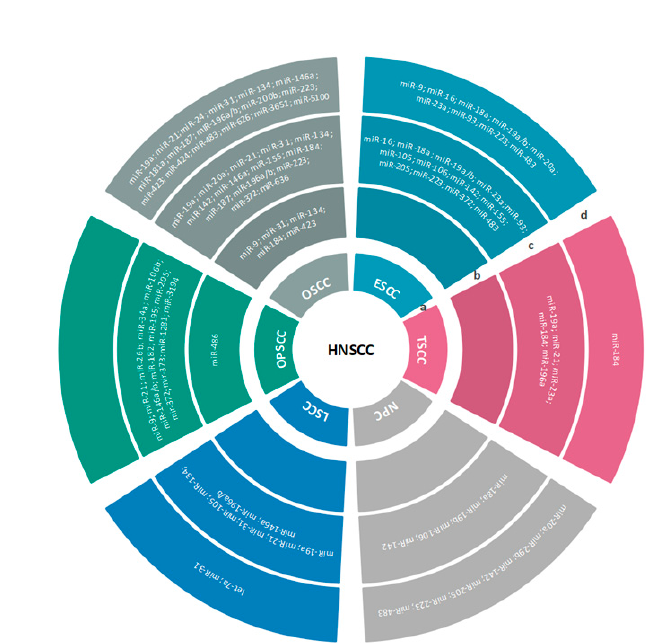
Figure 1. Overview of the most significant miRNAs that are upregulated in HNSCC. The first inner ring represents the subtypes of HNSCC ( a ); the second, third, and fourth rings represent miRNAs detected in saliva ( b ); tumor tissues ( c ); serum, plasma, or peripheral blood ( d ) of HNSCC patients.